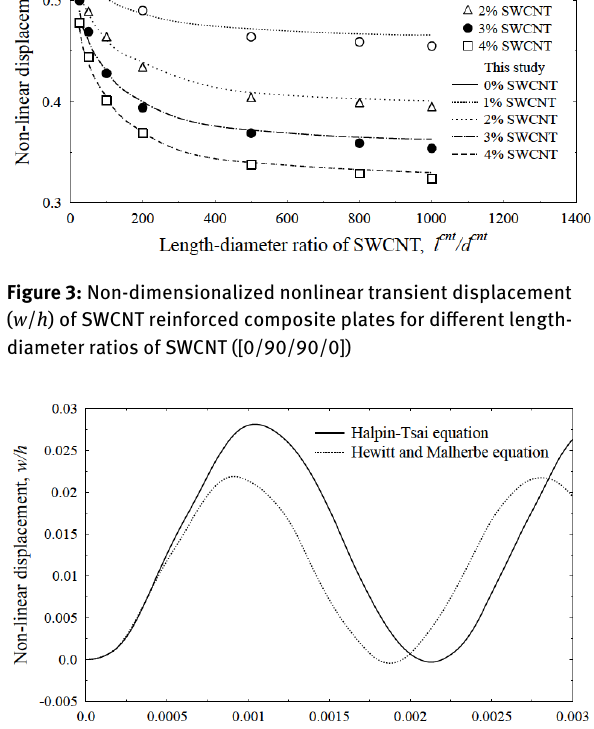
Figure 5 represents nonlinear transient displacements of [0/90] SWCNT reinforced composite flat plates and spher- s ical shells for different the SWCNT weight ratios. All param-